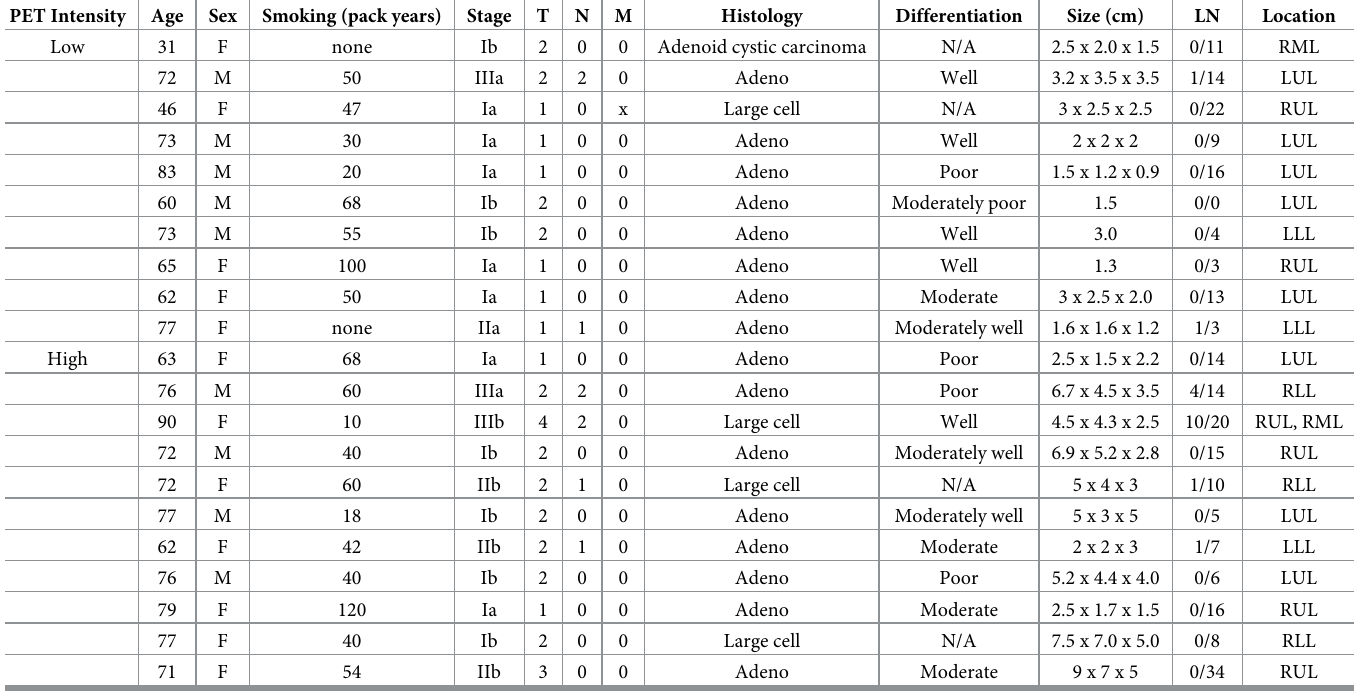
Table 2. Patient clinical